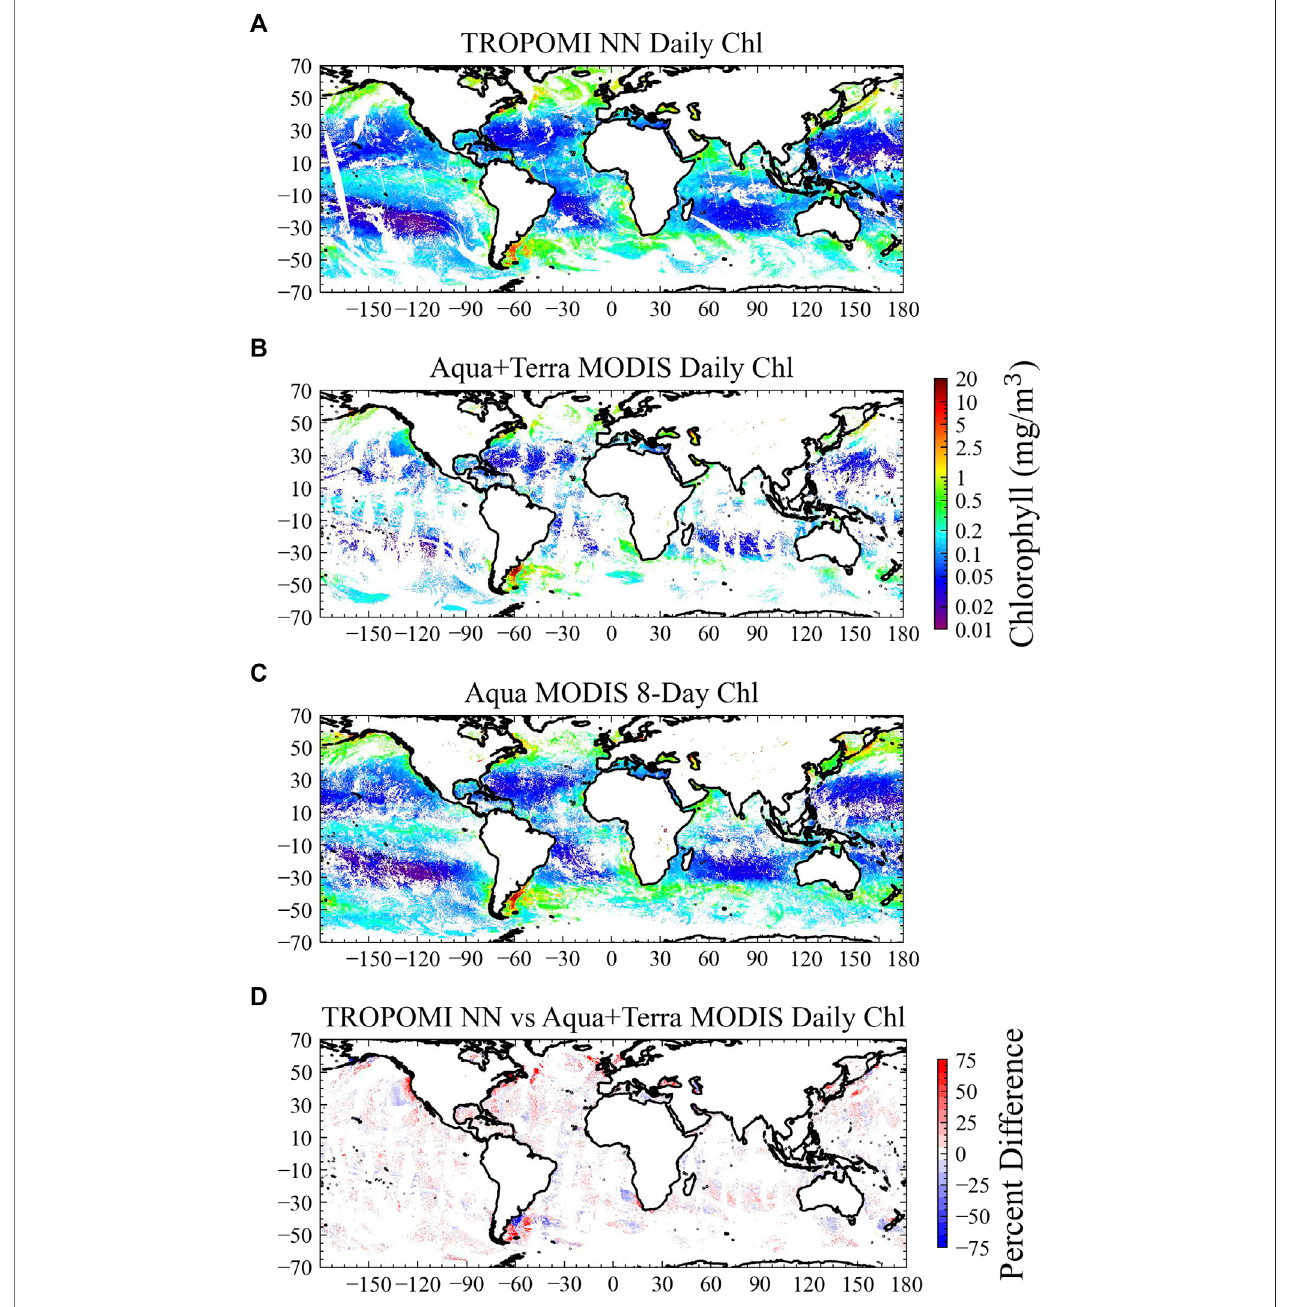
FIGURE 10 | Retrievals of chlorophyll for 15 October 2020 gridded to 4 km. (A) TROPOMI machine learning – based chlorophyll; (B) Aqua MODIS daily chlorophyll retrieval gap- fi lled with the Terra-MODIS daily chlorophyll retrieval; (C) Aqua-MODIS 8-day chlorophyll retrieval; (D) percent difference between the TROPOMI machine learning – based chlorophyll and the Aqua MODIS daily chlorophyll gap fi lled with Terra MODIS.